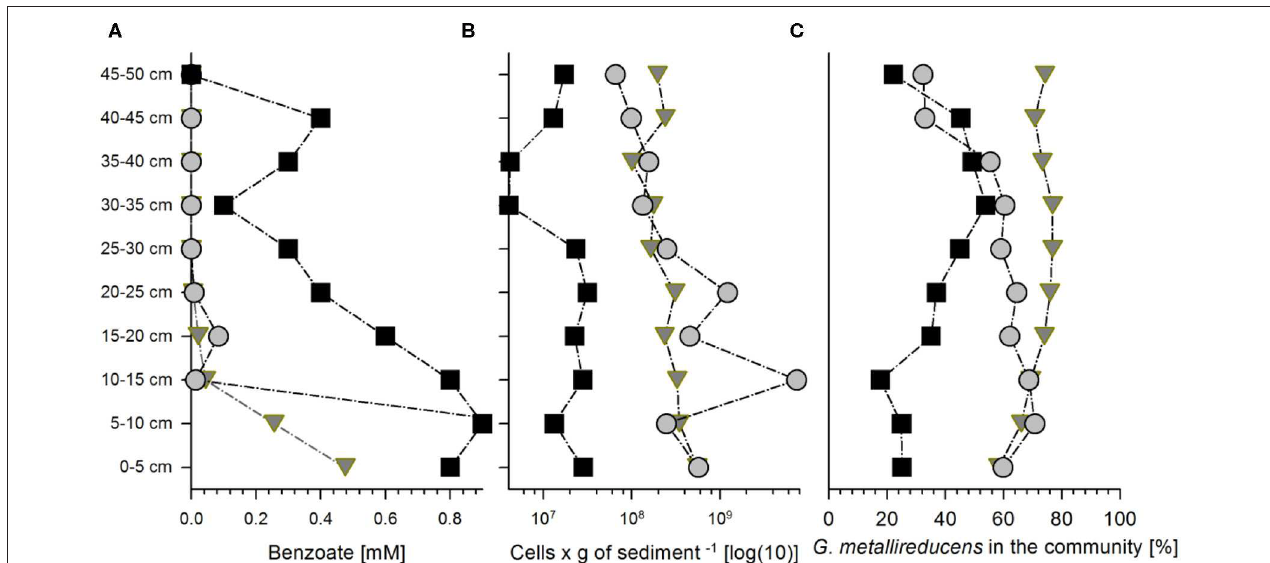
FIGURE 1 | Benzoate concentrations and bacterial abundances in the three sediment columns at the end of the cultivation at 300, 528, and 552h for columns 1 (squares), 2 (circles), and 3 (triangles), respectively. Concentrations of benzoate (A) , total bacterial cell counts (B) , and relative abundance of Geobacter metallireducucens in the communities according to the expressed percentage of normalized protein abundances of G. metallireducens from all the proteins detected (C) along the length of columns (for the distribution of the other community members please refer to the Figure S2